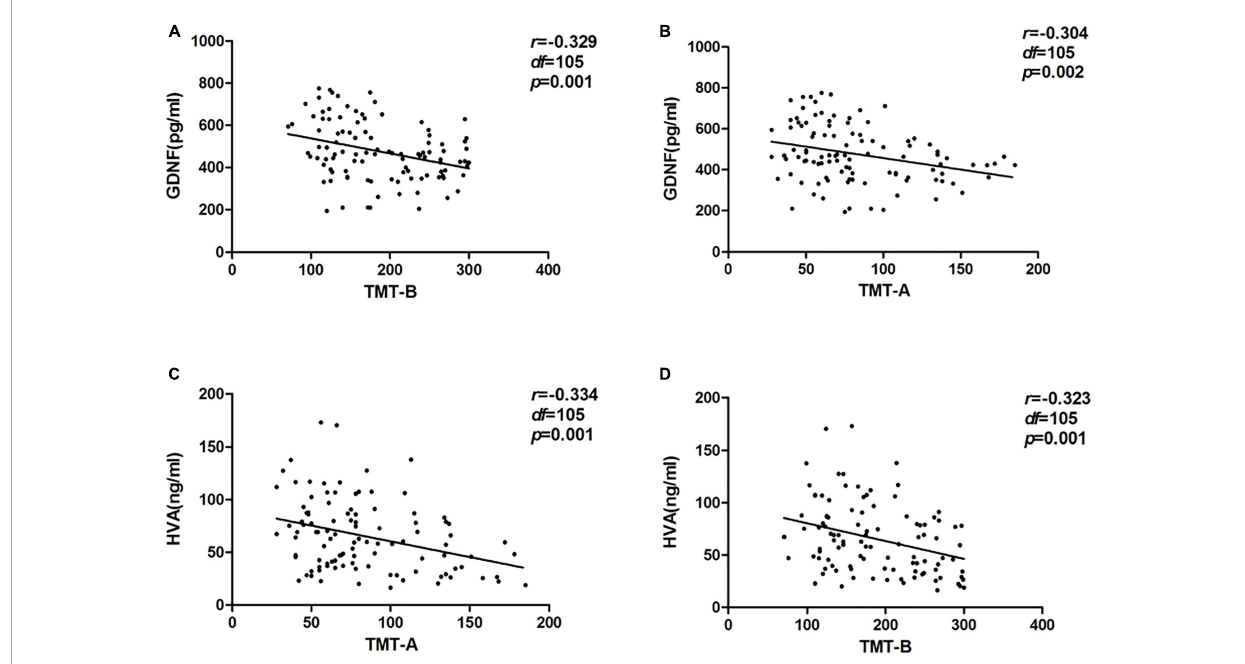
FIGURE2 Correlation between serum glial cell line-derived neurotrophic factor (GDNF) and homovanillic acid (HVA) concentrations and trail making test (TMT) in the PD group. (A) Correlation between serum GDNF concentration and TMT-A. (B) Correlation between serum GDNF concentration and TMT-B. (C) Correlation between serum HVA concentration and TMT-A. (D) Correlation between serum HVA concentration and TMT-B.